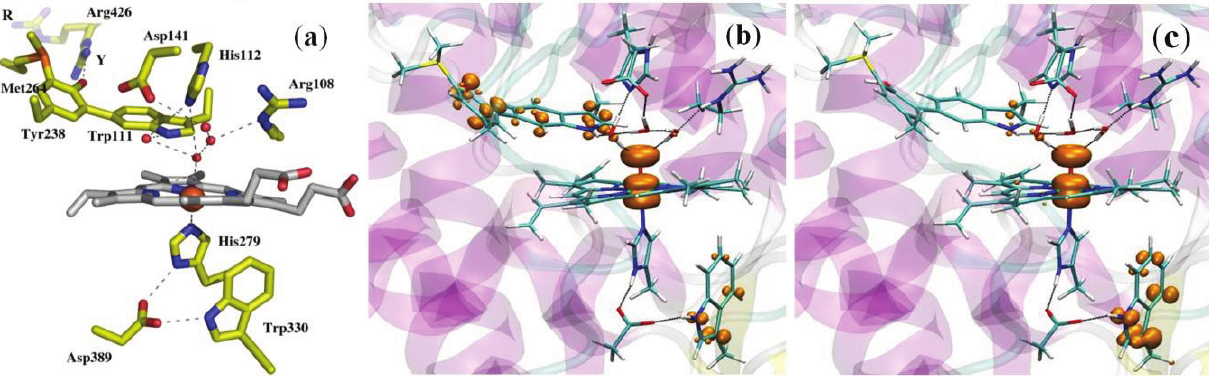
Figure 2. ( a ) KatG active site (PDB entry 1MWV); ( b , c ) the QM region is shown in